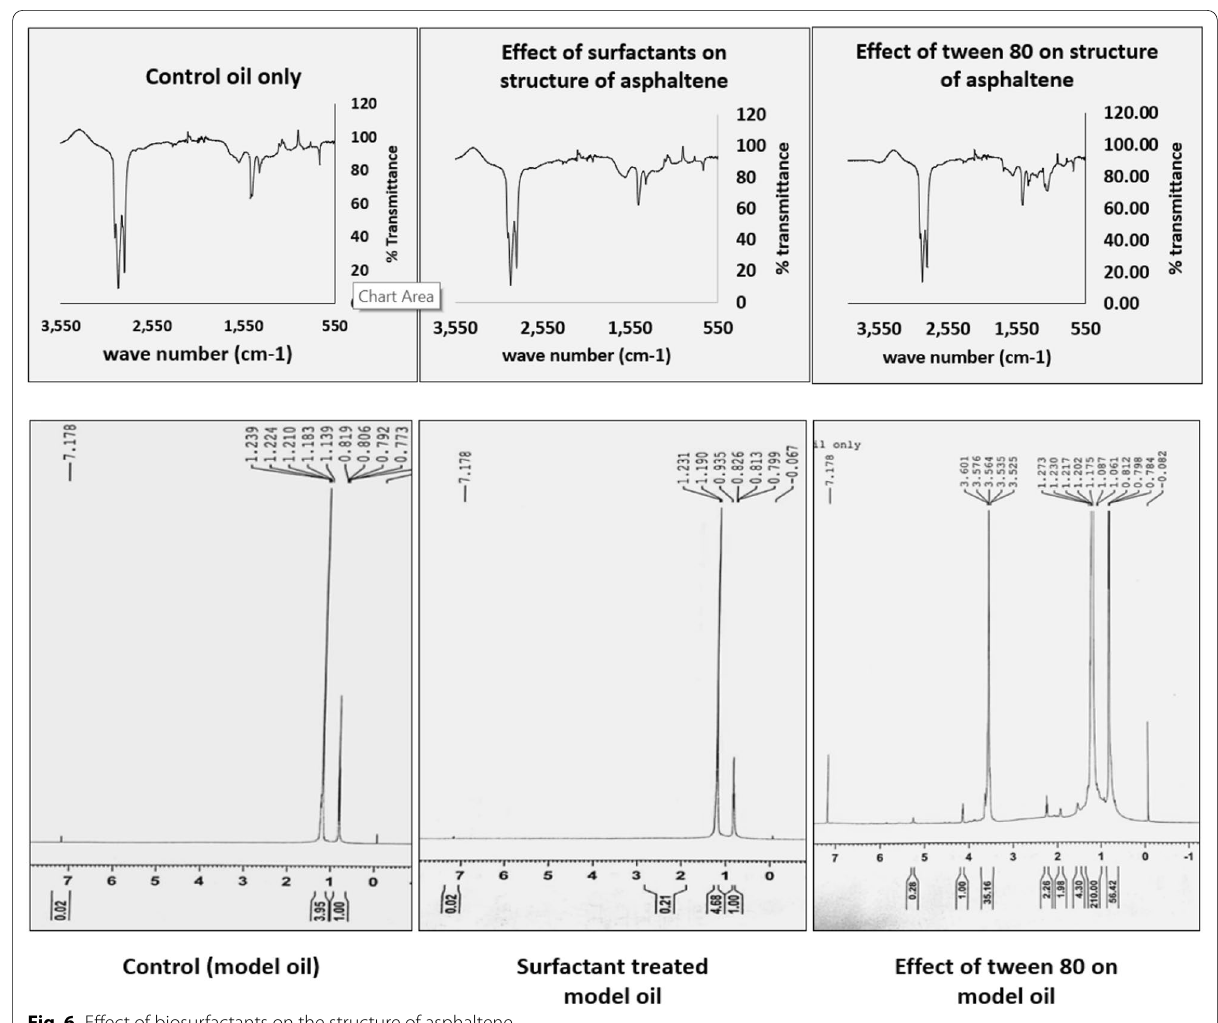
Fig. 6 Effect of biosurfactants on the structure of